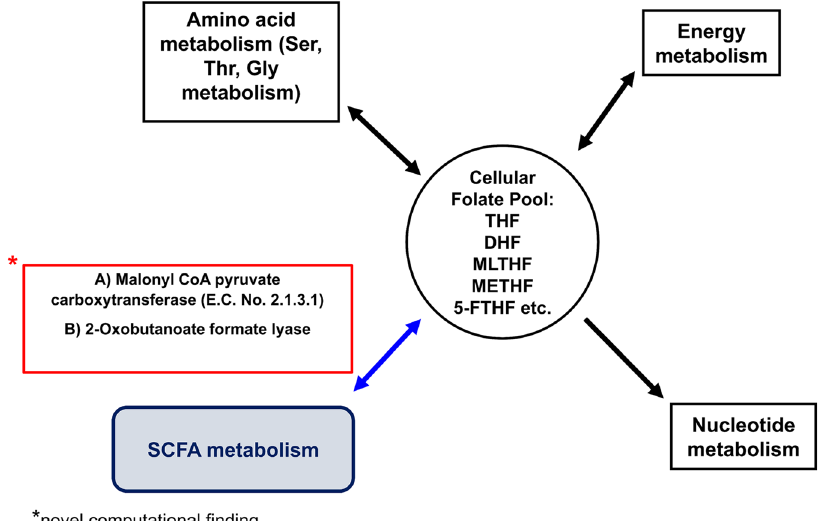
Fig. 4 Folate metabolism and its association with different central metabolic pathways. The metabolic pathways (viz., amino acid, energy and nucleotide metabolism), were in fl uenced by folate metabolism as predicted by the model. The link between SCFA metabolism and folic acid metabolic pathways is a novel model prediction that needs to be con fi rmed